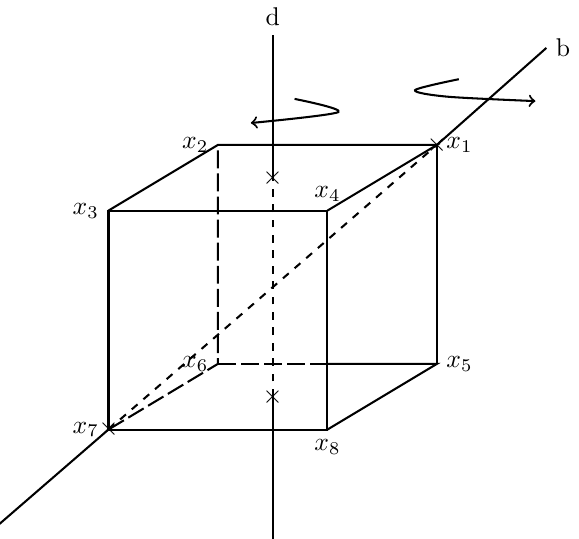
Figure 7. The group of proper rotations of a cube are isomorphic to S permutations of four objects. S 4 can be parameterized by [19] b 3 = d 4 = e , db 2 d = b and dbd = bd 2 b . The eight vertices exchange under S 4 as b : x 1